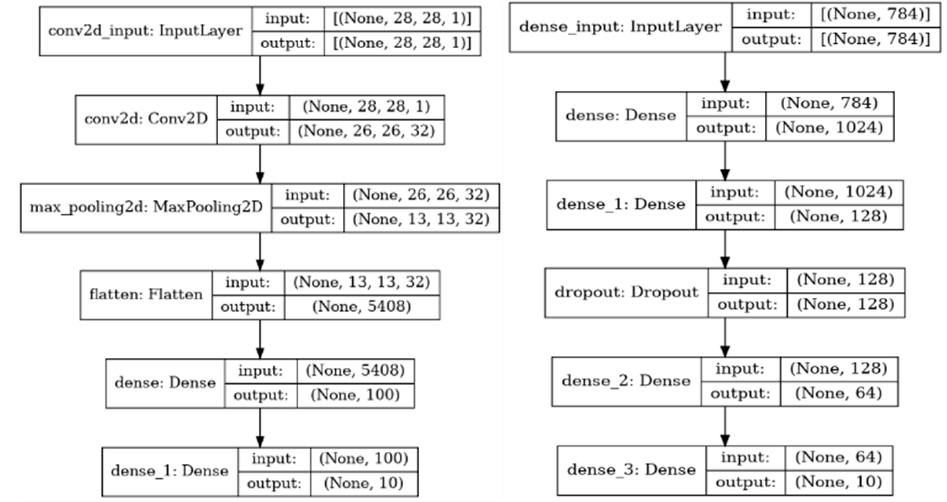
Figure 5. Examined neural network models.